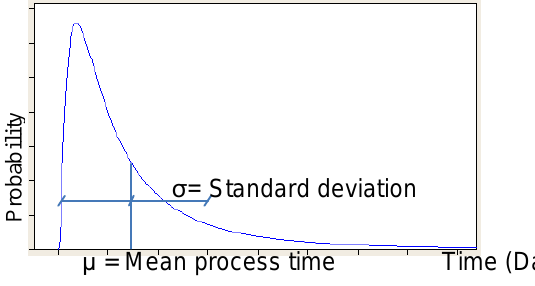
Figure 1 Probability density of cycle times for the construction production